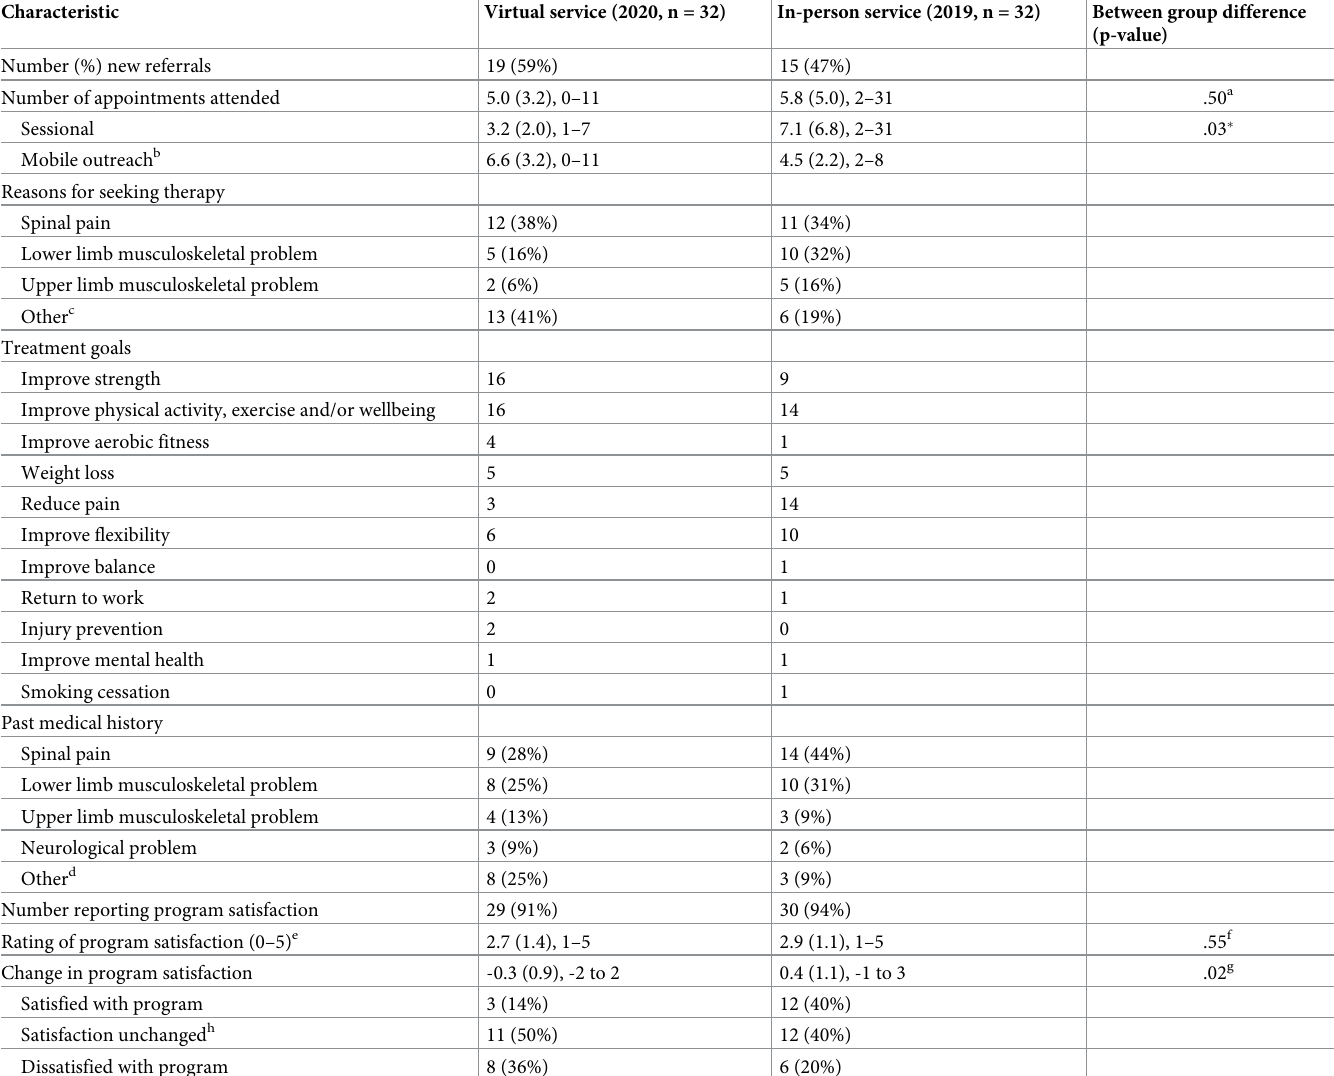
Table 2. Clinical characteristics of patients accessing the virtual service (March–September 2020) and historical controls (March–September 2019). Data reported as mean (SD), range; or n (%). Between-group differences were analysed using independent samples